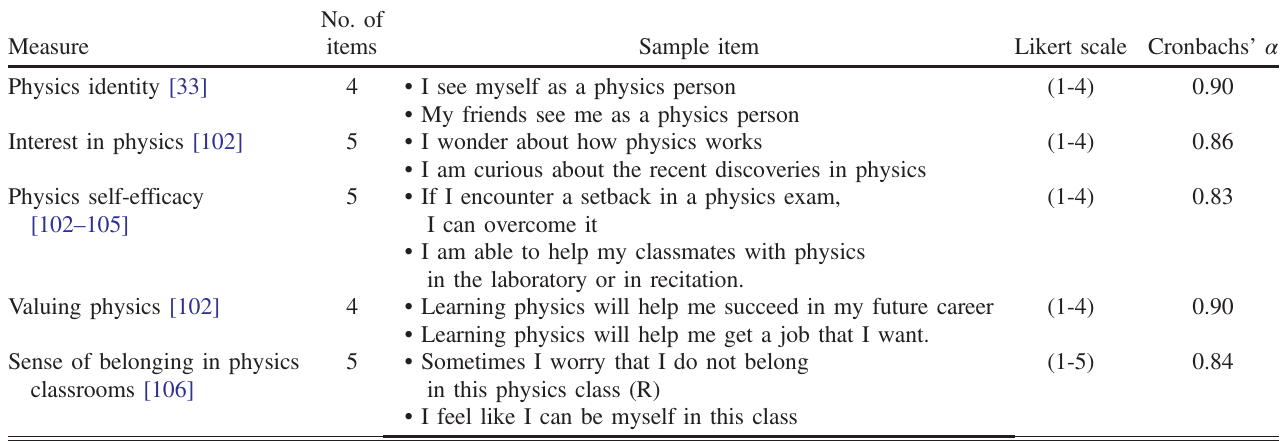
TABLE I. For each motivational construct, number of items, sample items, Likert scale range, and observed Cronbach α . The symbol R at the end of an item corresponds to a reverse coded item.